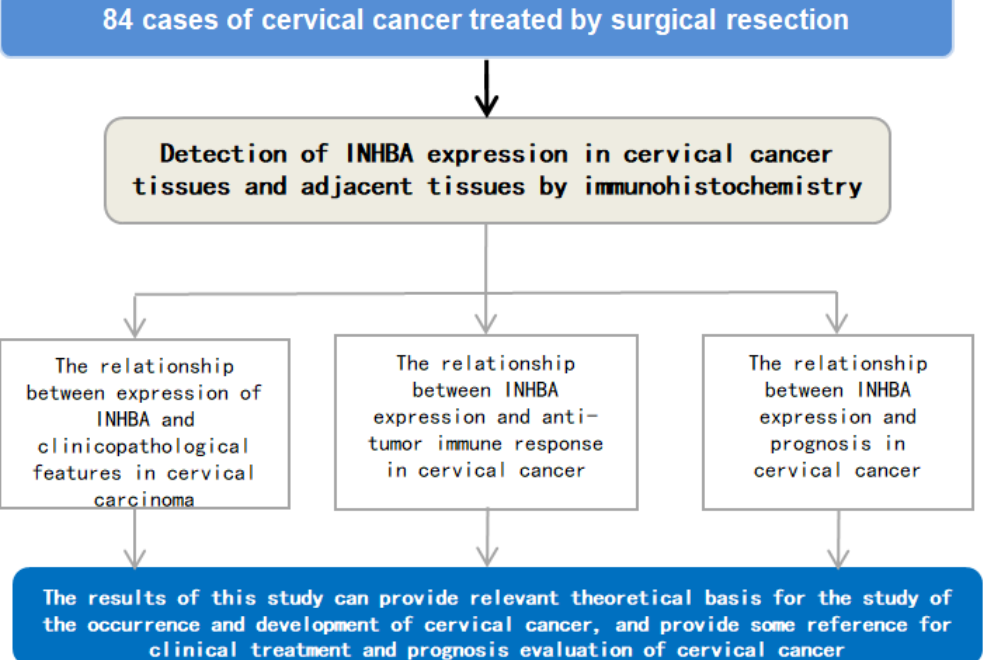
Figure 1. The experimental process. INHBA, inhibin beta